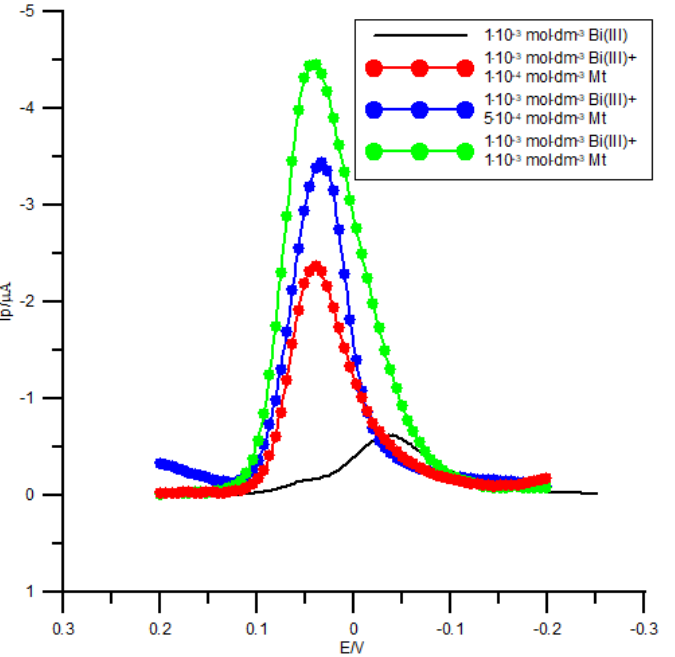
Figure 3. Net peaks of square-wave voltammetry (SWV) of 1 × 10 −3 mol dm −3 Bi(III) electroreduction in 1 mol dm −3 chlorate(VII) medium in the absence (black curve) and in the presence of increasing methionine concentration. The concentration of methionine is given on the plot. The parameters of the potential modulation are: Step potential 2 mV, pulse amplitude 20 mV and frequency 120 Hz.